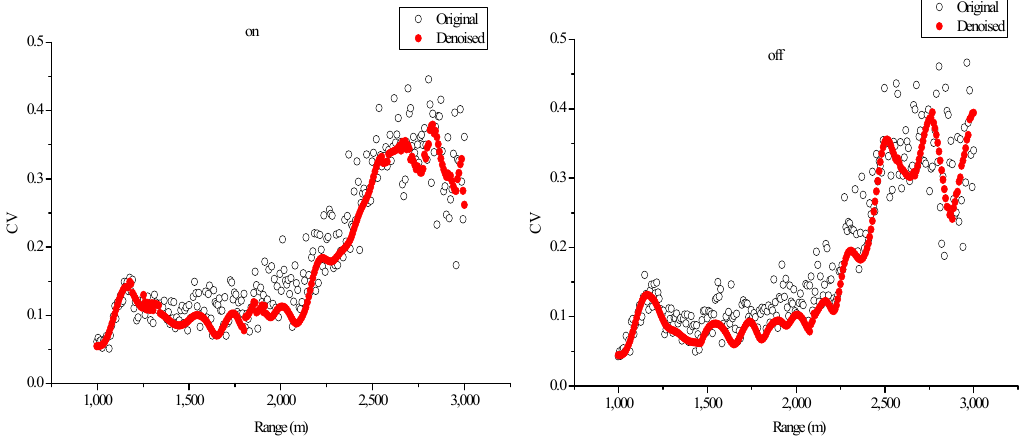
Figure 18. CVs of the original signals and denoised signals using EEMD (( left ) on ‐ line wavelength; ( right ) off ‐ line wavelength). Table 2. Average values of CV calculated by the original and denoised signals.